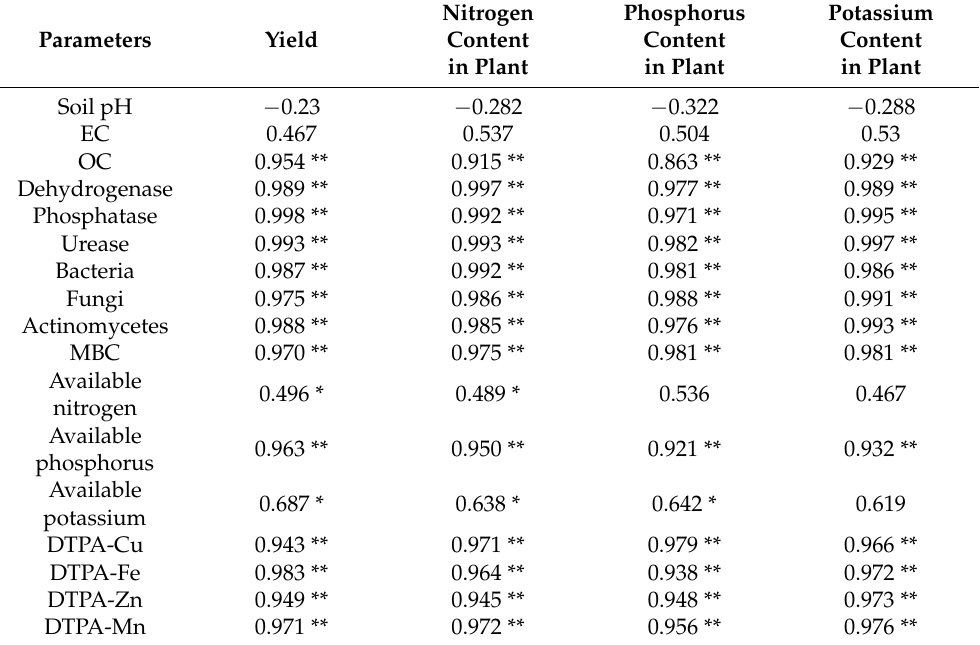
Table 7. Correlation of crop yield and nutrient content values with soil properties.